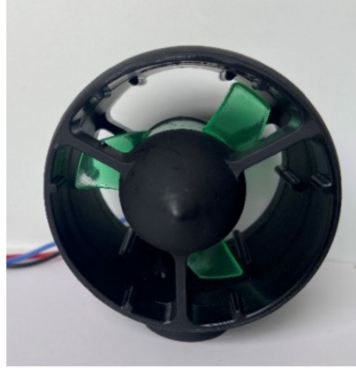
Figure 8. The thruster of